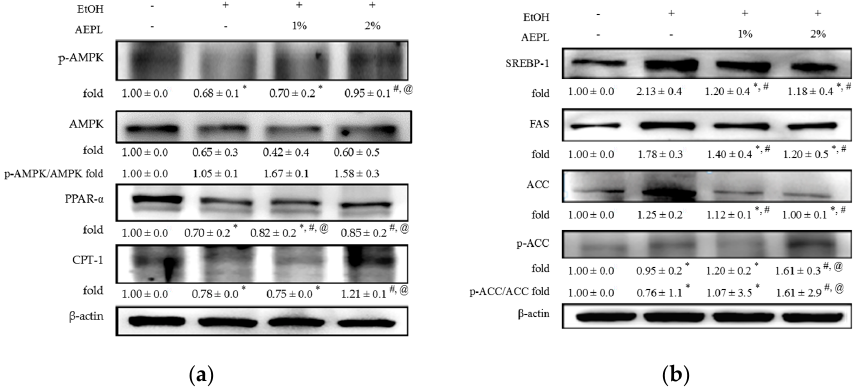
Figure 2. AEPL increased protein levels of p-AMPK, AMPK, PPAR- α , and CPT-1, and decreased protein levels of SREBP-1, FAS, p-ACC, and ACC. ( a ) Protein levels of p-AMPK, AMPK, PPAR- α , and CPT-1. ( b ) Protein levels of SREBP-1, FAS, ACC, and p-ACC. Data were presented as mean ± SD